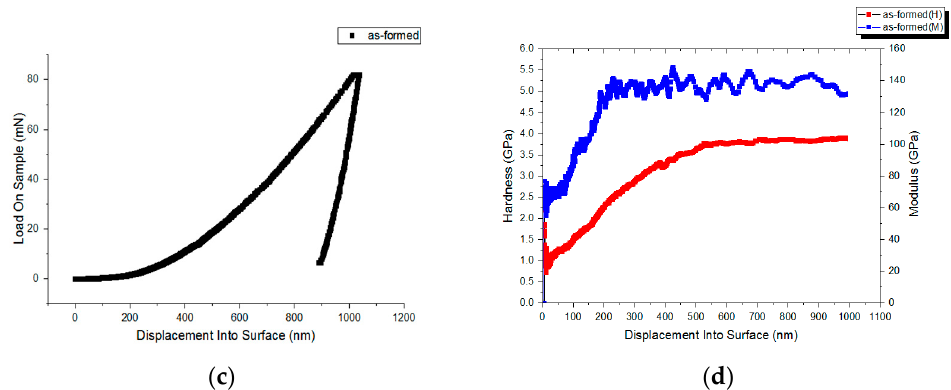
Figure 10. Characteristic load vs. nanoindentation depth for ( a ) substrate and ( c ) anodized sample. Hardness and modulus vs. nanoindentation depth for ( b ) substrate and ( d ) anodized sample.